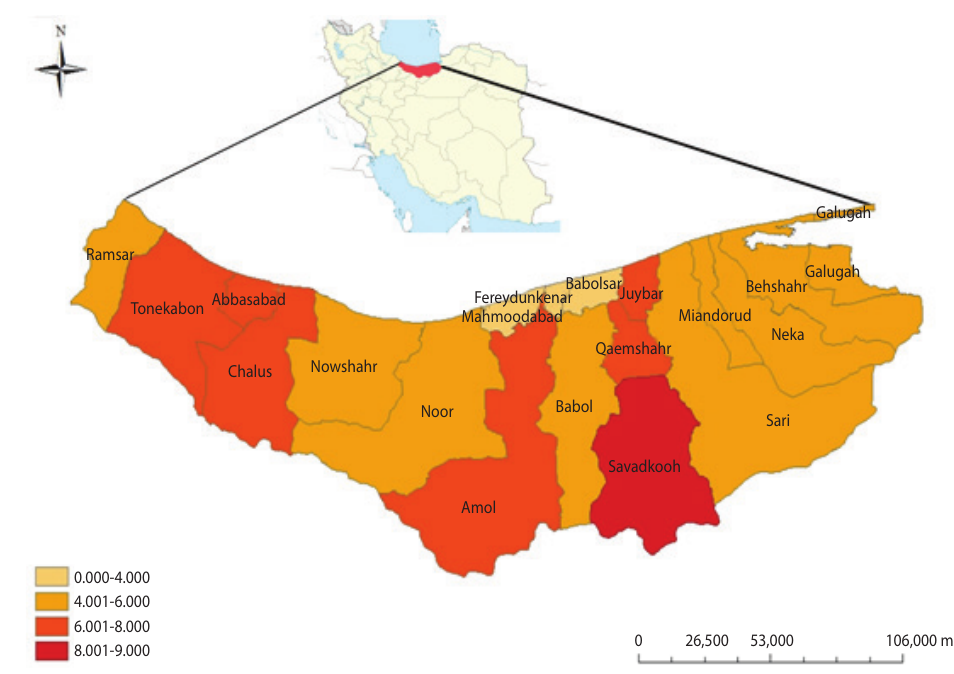
Figure 1. Spatial distribution of Blastocystis hominis among the general population in Mazandaran Province. The light-colored areas had the lowest Blastocystis rates, while the dark areas had the highest rates by ArcGIS 9.2